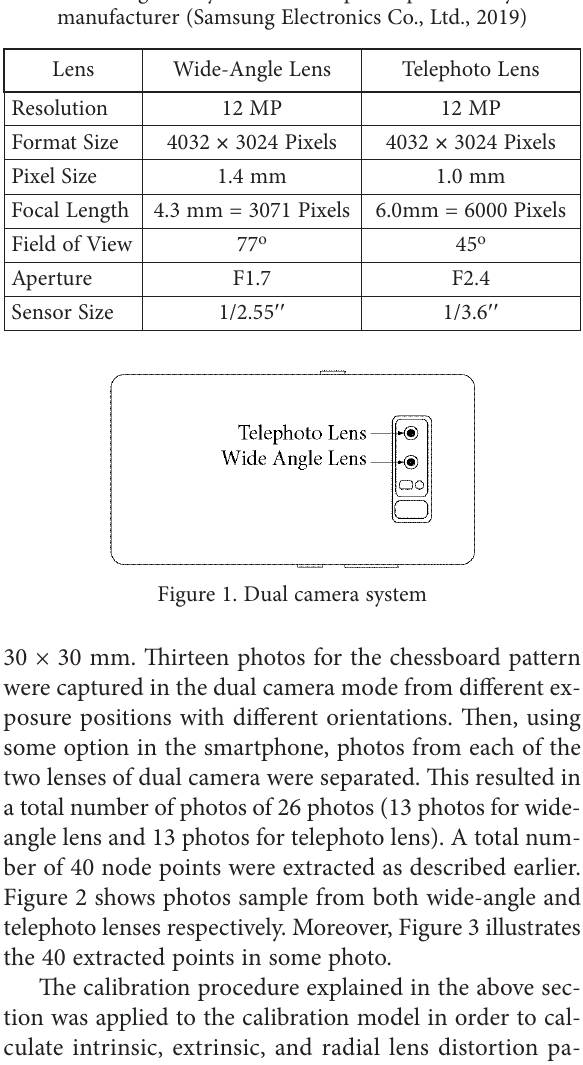
Table 1. Specifications of wide-angle and telephoto lenses for Samsung Galaxy Note 8 Smartphone provided by the